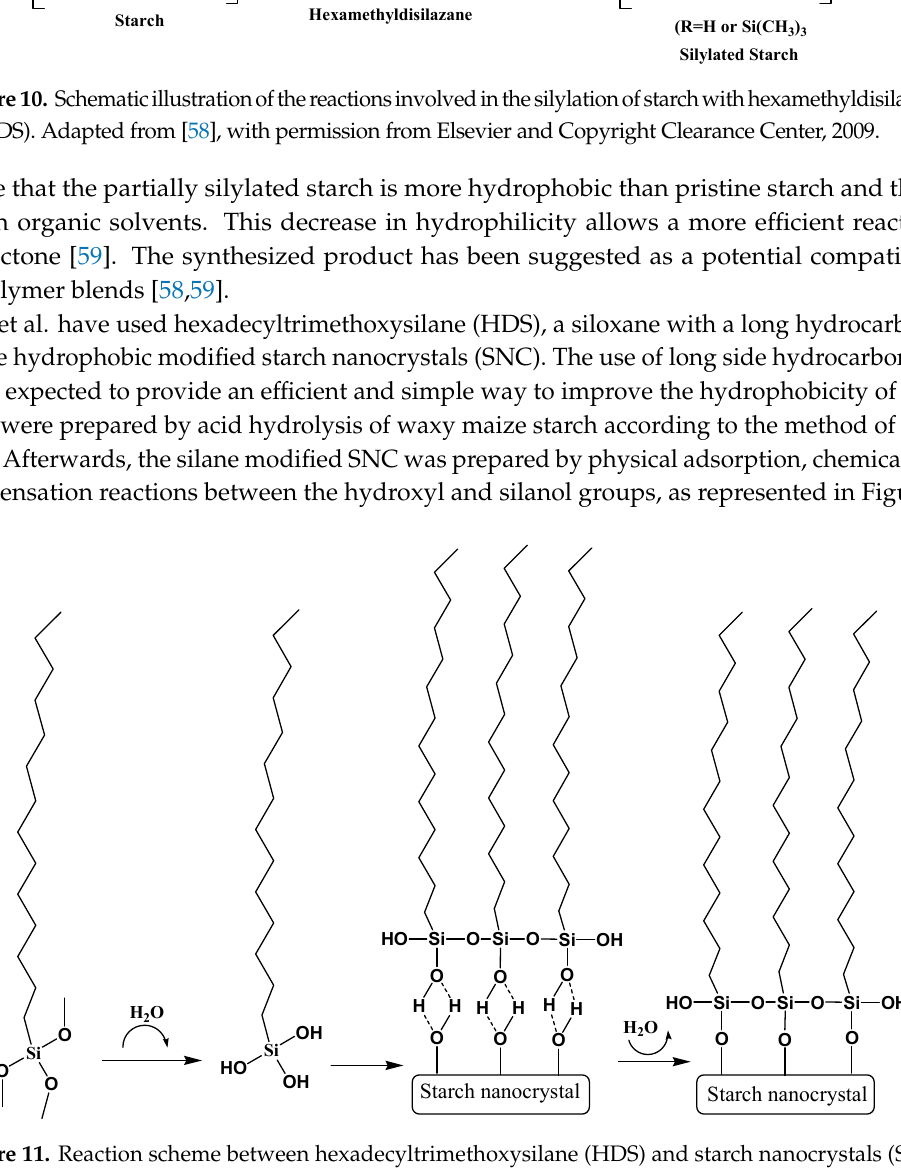
Figure 12. Photographs of a water drop on the surface of SNC and silylated SNC. Adapted from [60],